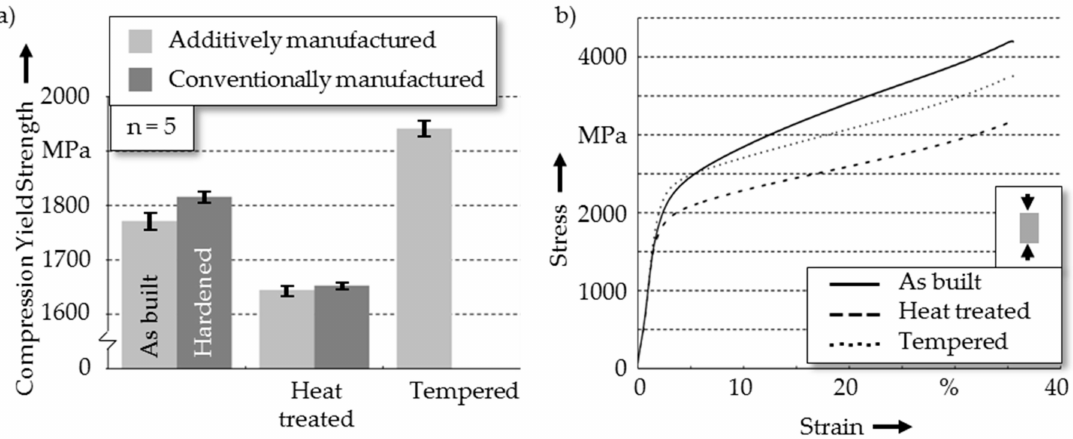
Figure 6. Results of compression tests with an analysis of ( a ) the compression yield strength and ( b ) the stress-strain curves exemplarily for one of the specimens with different heat